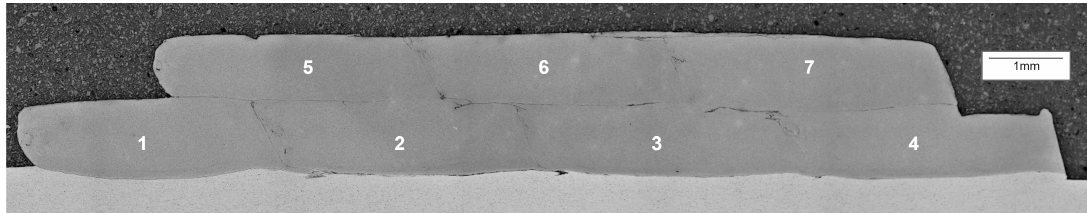
Figure 16. Section through the sample shown in Figure 2b with deposition order of the individual stringers indicated. The structure is almost fully dense, yet some pores and areas with lack of bonding are